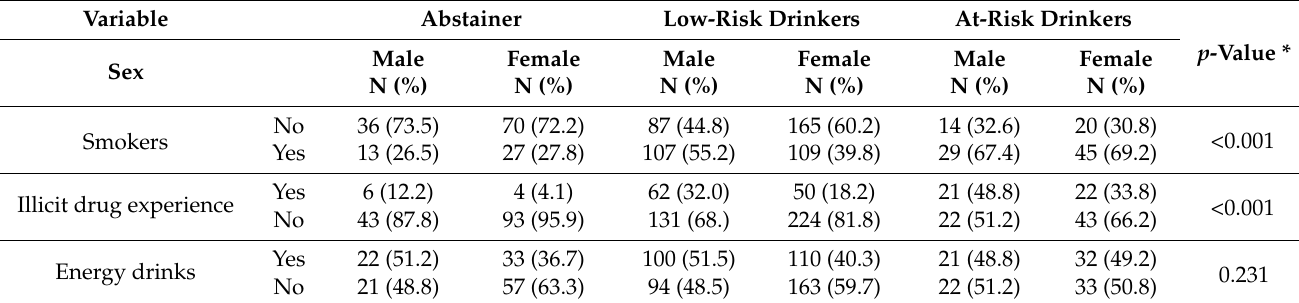
Table 2. Behaviors associated with alcohol consumption in the medical school students surveyed.